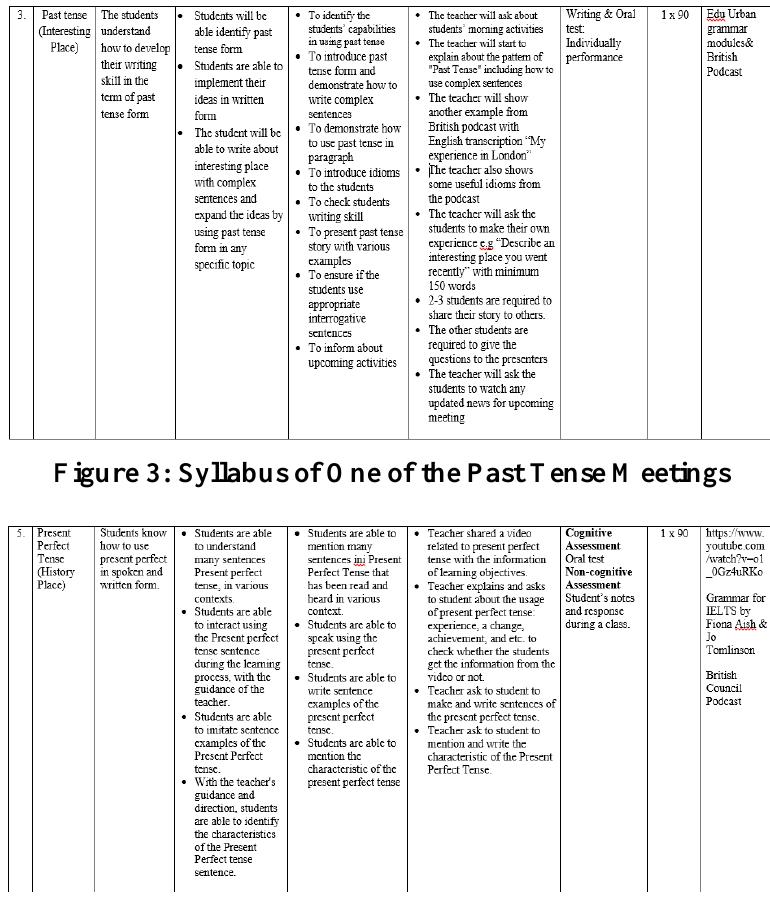
Figure 4: Syllabus of One of the Present Perfect Tense